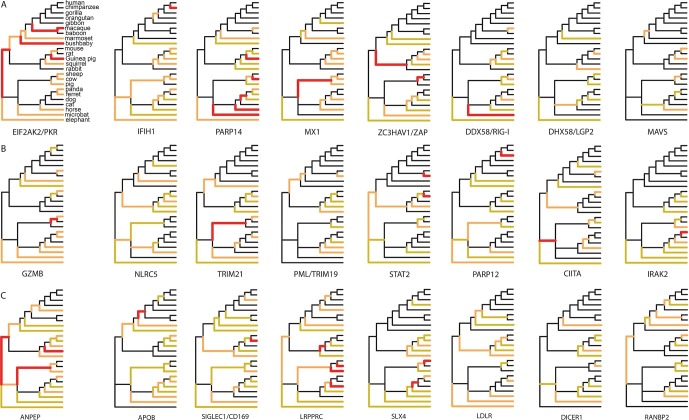
Examples of mammalian orthologs with adaptation spread across clades.(A) Signals of adaptation in eight antiviral proteins with well-known adaptation across mammals. Red: BS-REL p≤0.001. Orange: BS-REL p≤0.05. Yellow: BS-REL p≤0.1. (B) Top eight antiviral proteins with the highest number of branches under selection, and no previously know adaption spread across mammals. Note that adaptation was previously found for TRIM21 in primates but no other mammalian clade (Malfavon-Borja et al., 2013). (C) Top eight non-antiviral proteins with well-known functions and the highest number of branches under selection across mammals. Proteins are ordered according to the number of branches with signals of adaptation.